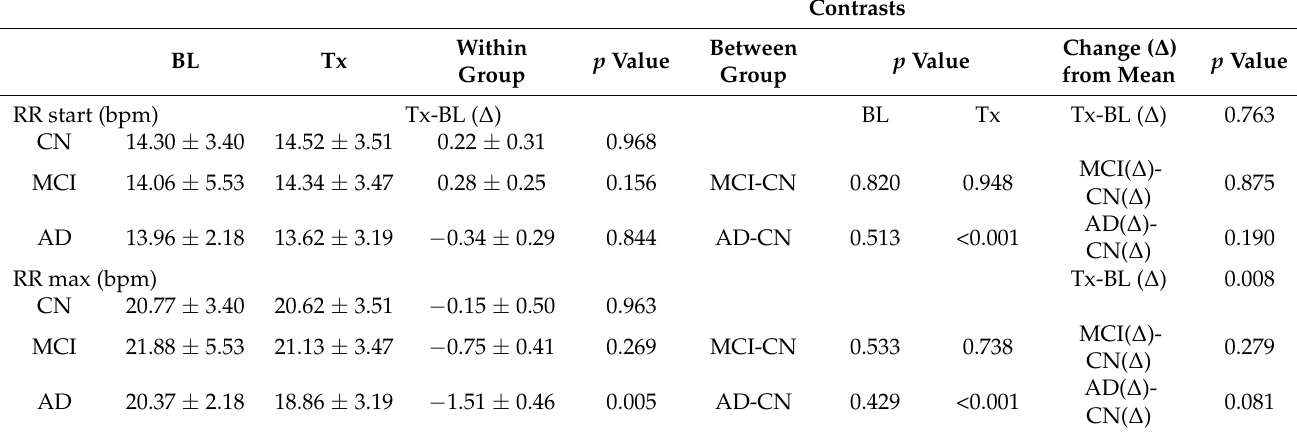
Table 3. Comparison of intervention group respiration rate start, maximum and fluctuation during stable sleep periods. BL